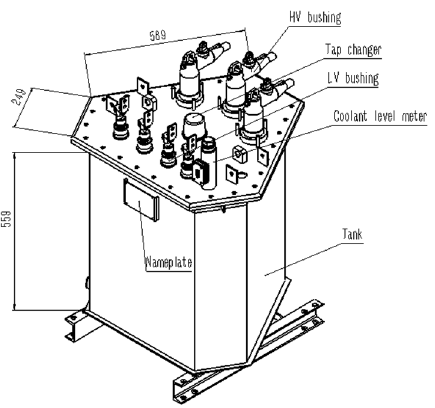
Figure 4. Design of evaporative cooling transformer tank.